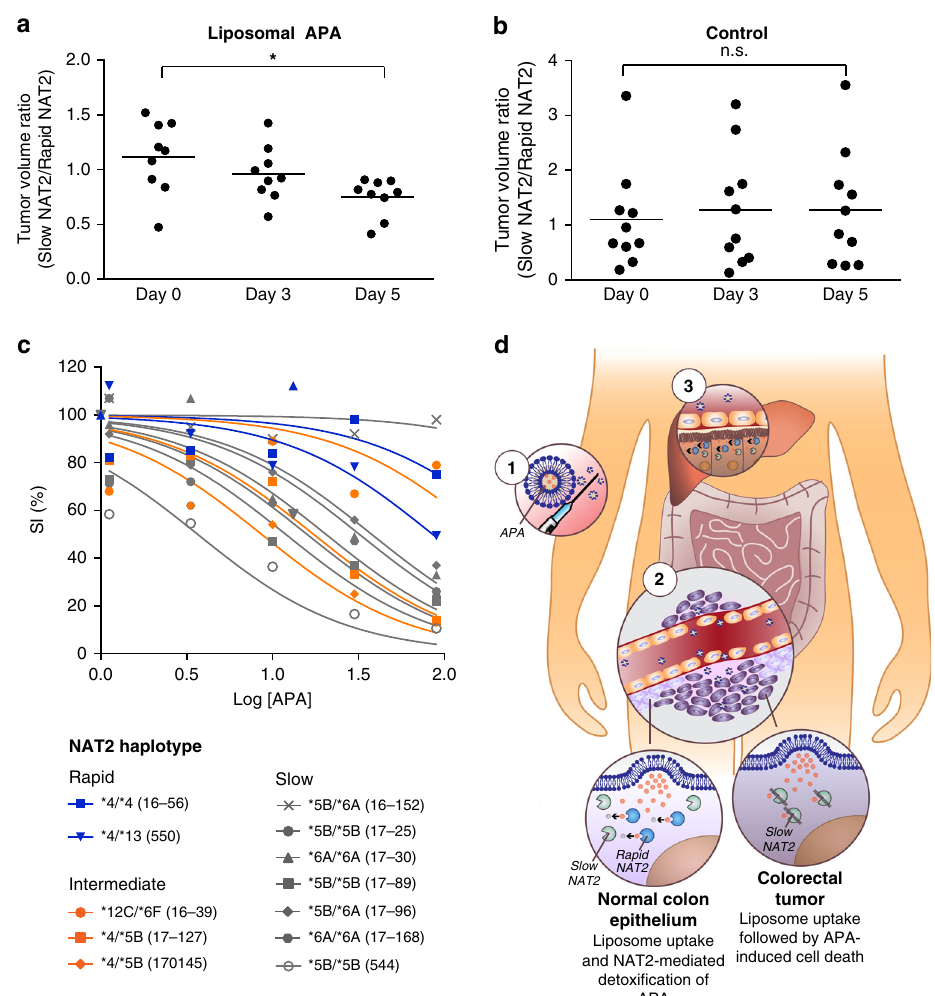
APA selectively inhibits growth of slow NAT2 tumors in vivo. Athymic nude mice carrying subcutaneous slow (left fl ank) and rapid (right fl ank) NAT2 RKO cell clones received intravenous injections of liposomal APA on days 0 and 3. Results are shown for one representative experiment conducted in 9 mice for the treatment group and 10 mice for the control group. Data were analyzed using one-way ANOVA, n.s., P = 0.9013 and * P = 0.0220. c Primary